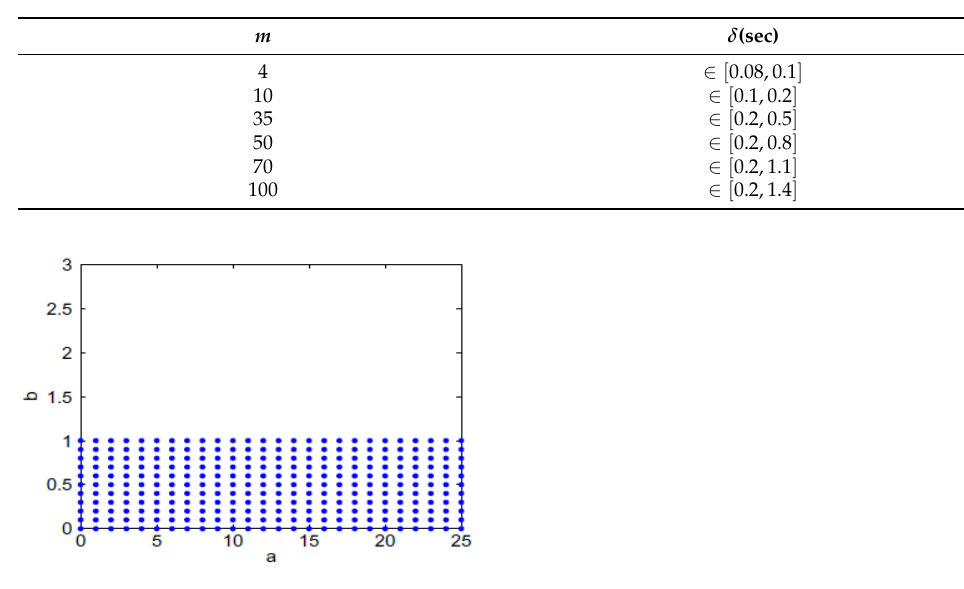
Figure 1. Stability regions using Theorem 1.